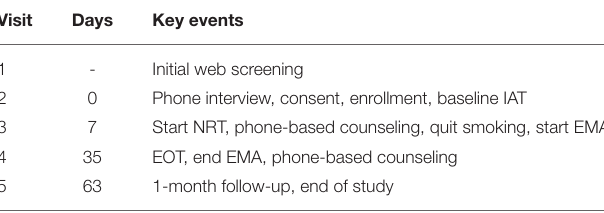
TABLE 1 | The visit structure for the hypothetical study. TABLE 2 | A representative smoking IAT experiment.